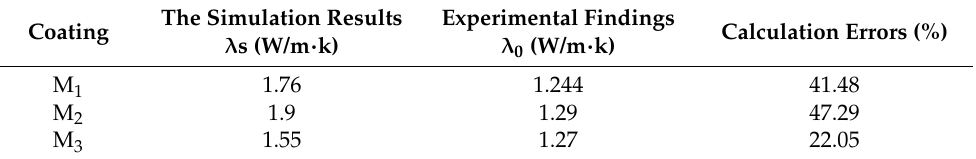
Table 4. The comparison of theoretical results λ s and experimental results λ 0 .